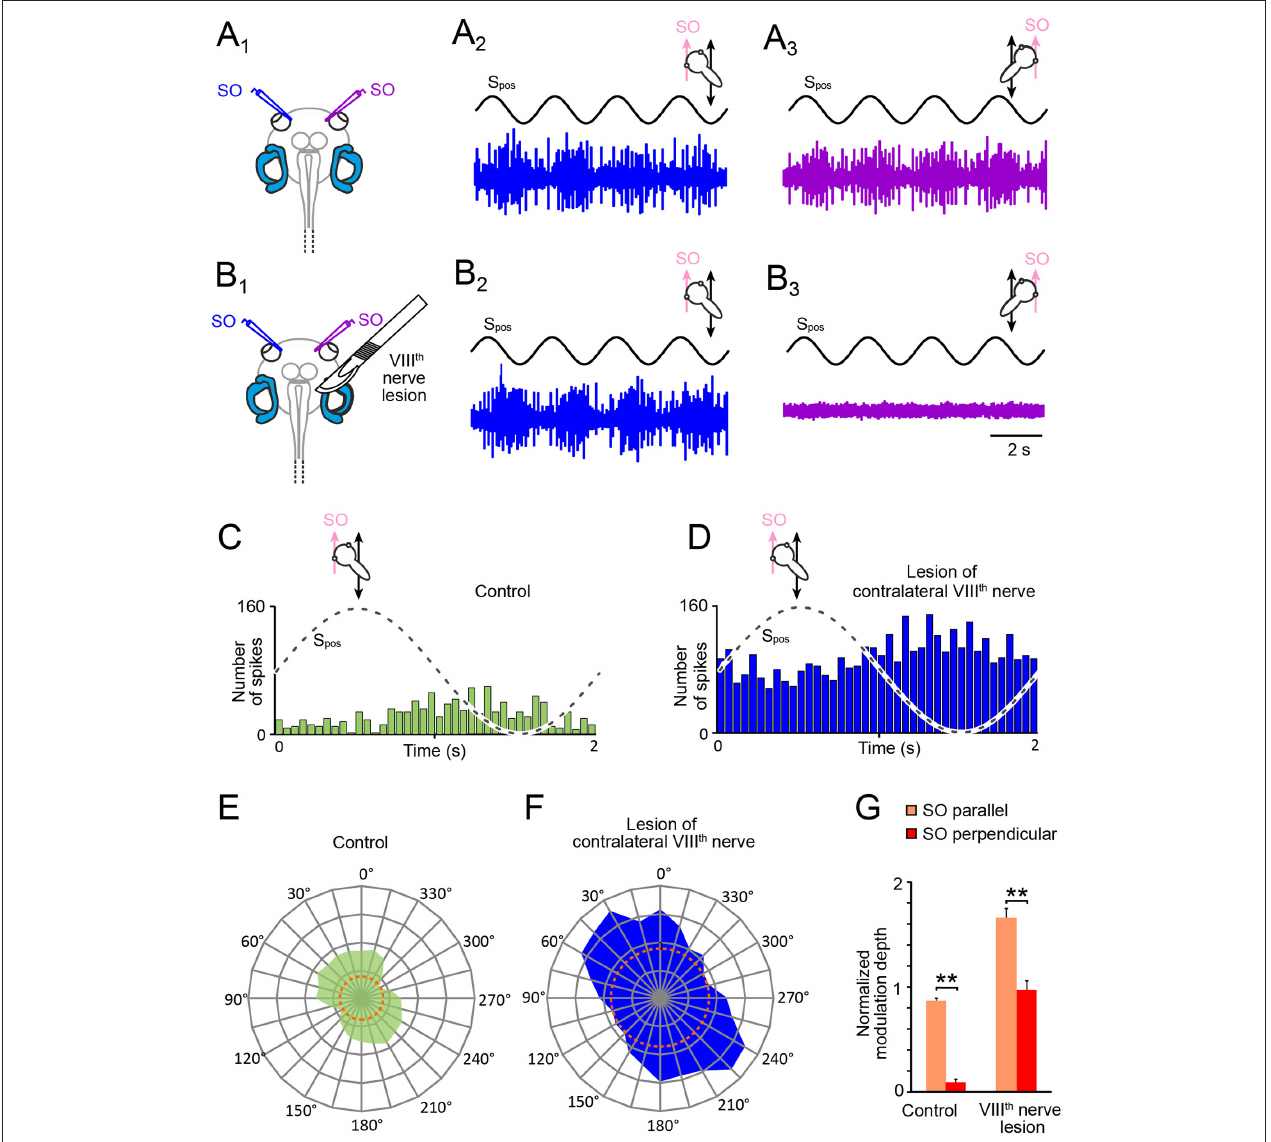
FIGURE 3 | Consequences of unilateral VIIIth nerve lesions on motion-induced SO nerve firing rate modulation. (A,B) Discharge modulation of bilateral SO nerves during four cycles of sinusoidal horizontal linear translation on a sled at 0.5Hz and 0.49 m/s 2 peak acceleration (S pos ; black traces) before (A 1 ) and after transection of the right VIIIth nerve (B 1 ) ; for maximal discharge modulation, preparations were positioned such that the left ( A 2 ,B 2 ; blue traces) and right SO muscle ( A 3 ,B 3 ; violet traces) were oriented parallel to the translation direction, respectively; note the complete loss of SO nerve spike activity on the ipsilesional (B 3 ) and persistence of firing rate modulation on the contralesional side (B 2 ) . (C–F) PSTHs (bin width: 50ms) of averaged firing rate modulation over a single cycle (dashed sine waves in C,D ) of sled motion (from n = 20–30 cycles) and polar plot of modulation magnitudes across 360 ◦ of translational motion (E,F) of the contralateral SO nerve before (C,E) and after VIIIth nerve transection (D,F) ; data in (C–F) derive from the typical example depicted in (A,B) ; dotted orange circles in (E,F) indicate the respective resting discharge rates. (G) Bar plot of normalized SO motor nerve firing rate modulation during translation parallel (orange) and perpendicular (red) to the SO eye muscle pulling direction ( n = 8) before and after VIIIth nerve transection. SO, superior oblique; S pos , stimulus position of the